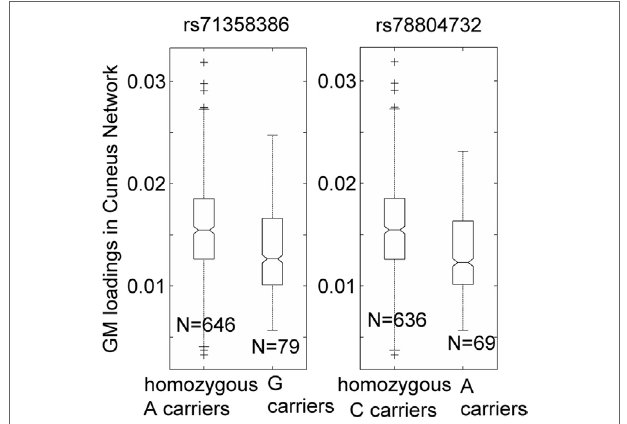
FigUre 2 | Association of two single-nucleotide polymorphisms, rs71358386 and rs78804732, with a cuneus gray matter (GM) component. GM loadings are relative values without unit. In the box plots, the middle line is the median value, the top and bottom of each box are the 25th and 75th percentile values, the whiskers extend from the ends of the interquartile to the further values within 1.5 times the interquartile, and plus ( + ) signs show values that are more than 1.5 times the interquartile range away from the top or bottom of the box. The plot of medium and 25/75th percentile presents a similar overall pattern as the mean and standard deviation in these